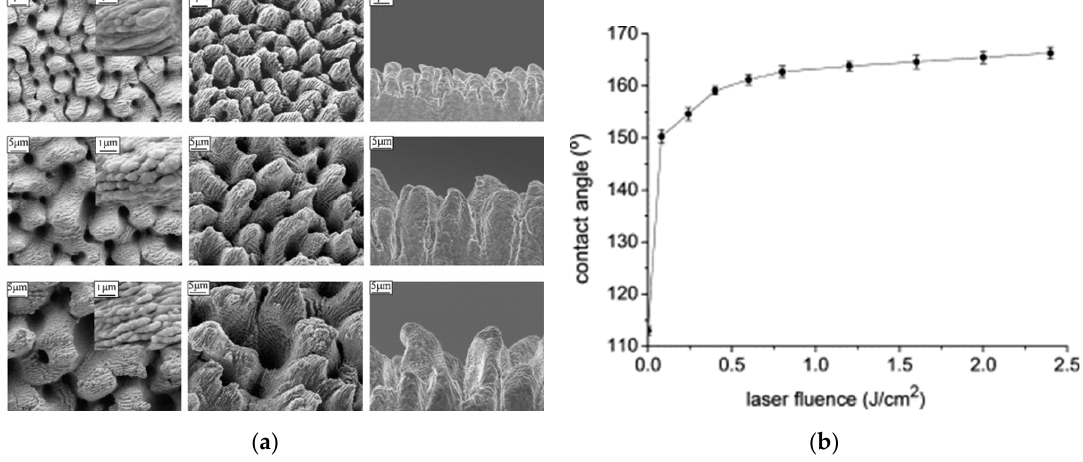
Figure 15. Surface structure and wetting performance of AISI 316L. ( a ) Micro/nano hierarchical structures; ( b ) apparent water CAs as a function of corresponding laser fluences. “Reprinted with permission from Ref. [56] , Copyright (2009), Elsevier”.